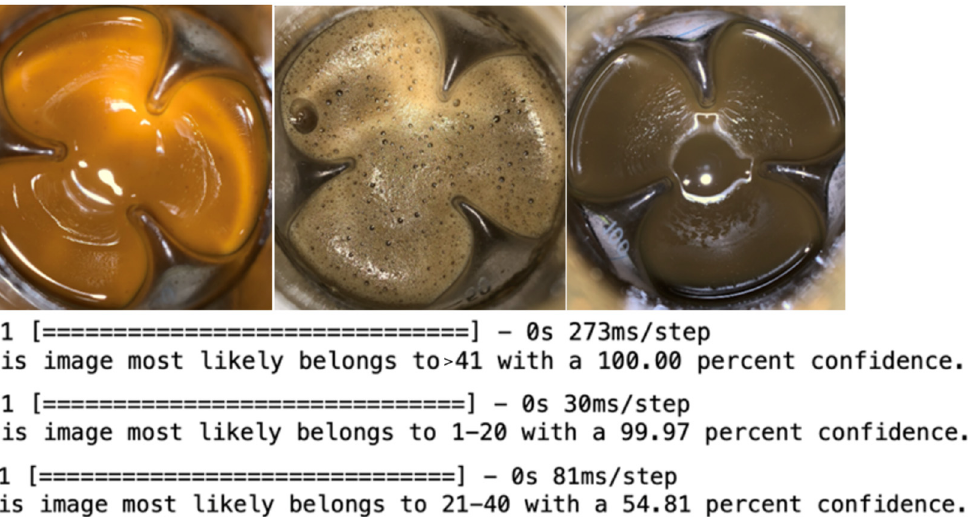
Figure 6. The fermentation medium images that did not belong to the dataset; the upper, middle, and lower images represented the predicted PMLA production of the pictures from left to right.